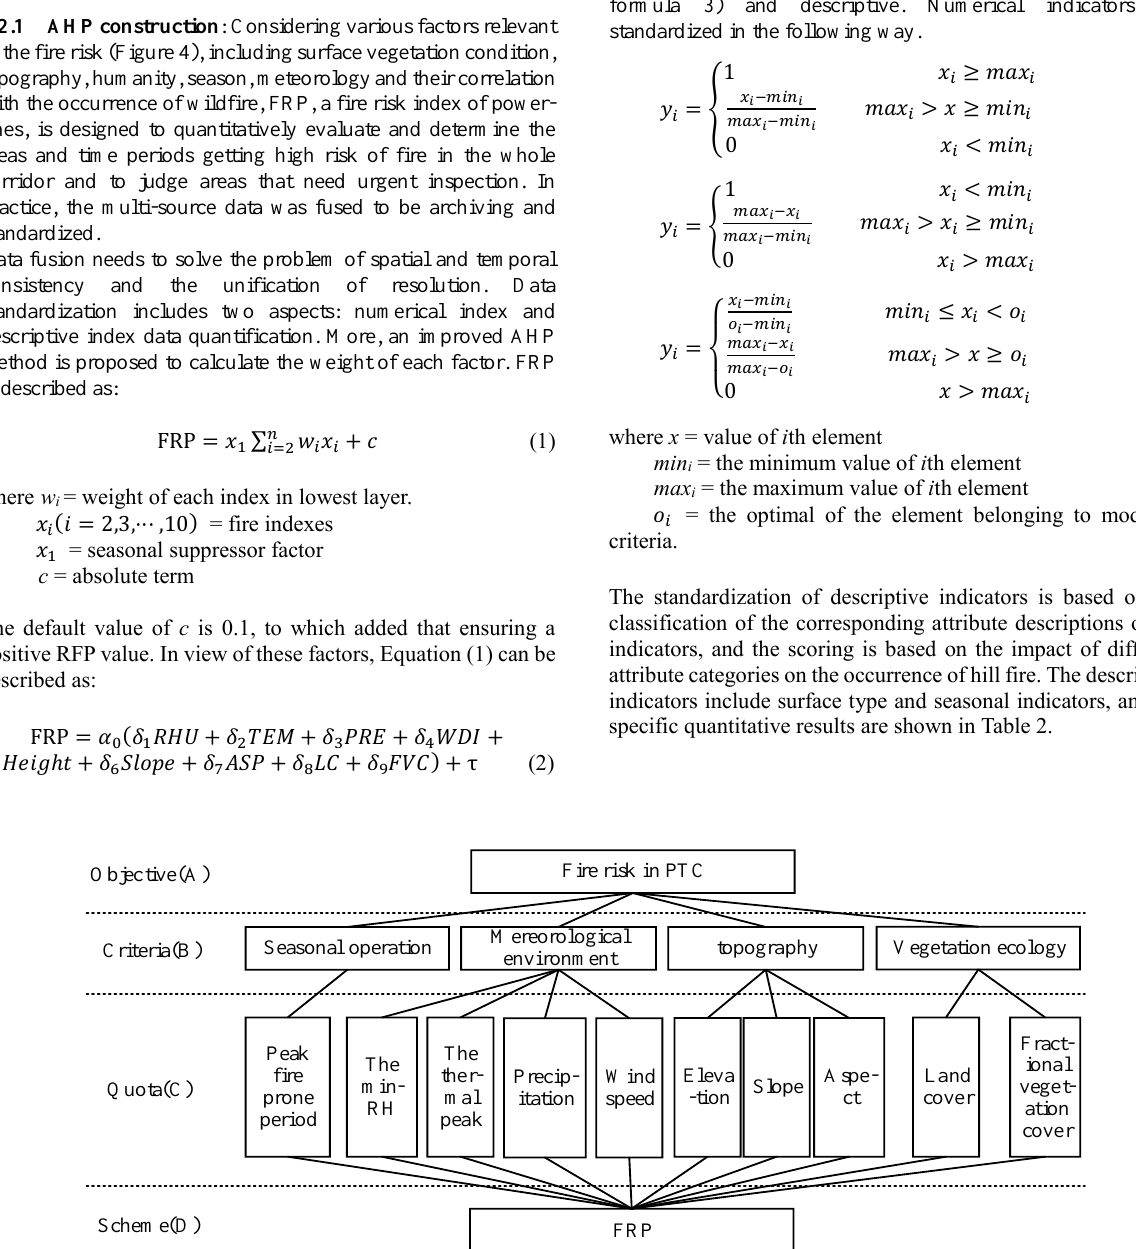
Weight calculation : indicators are classified as numerical (positive, formula 1, negative, formula 2, moderate,